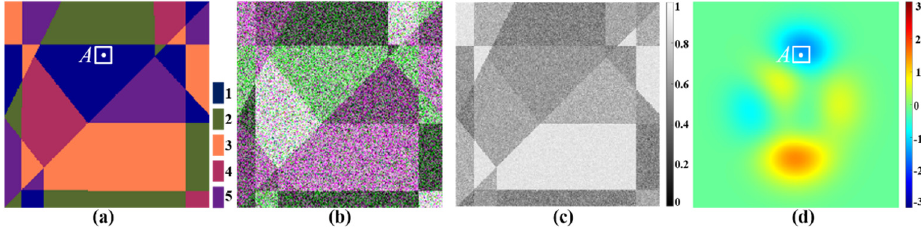
Figure 3. Flowchart of the proposed MT-InSAR strategy.